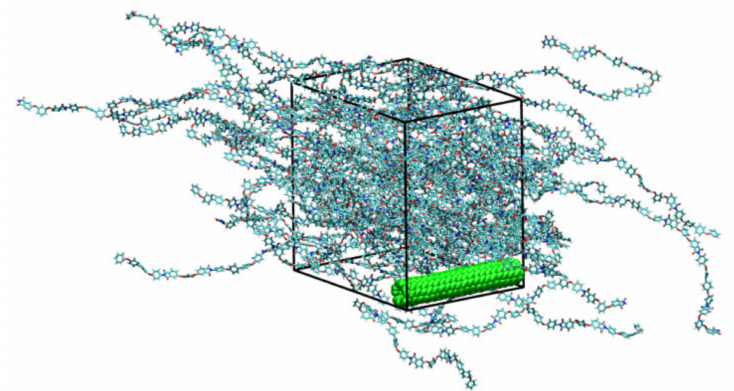
Figure 2. Instant configuration of the SWCNT-R-BAPB nanocomposite after 10 µ s-long simulations. The SWCNT’s atom is shown in green on a snapshot. The nanotube is periodic and passes through all periodic images of a simulation box. We generated the snapshot using VMD package